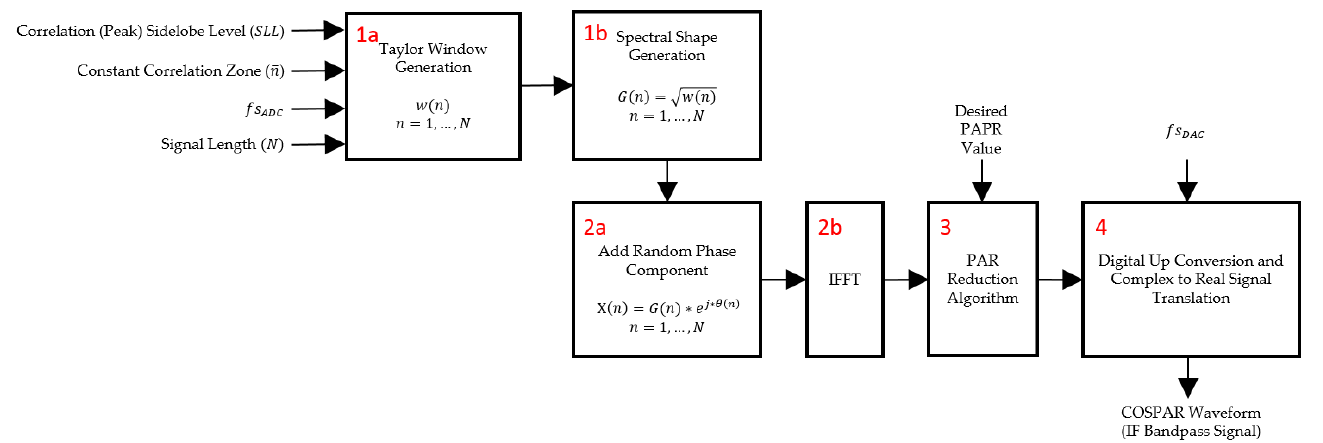
Figure 5. Block diagram of COSPAR waveform synthesis method.